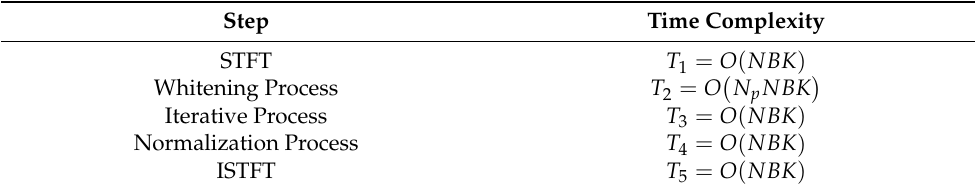
Table 5. Calculation of the time complexity required by the main program.